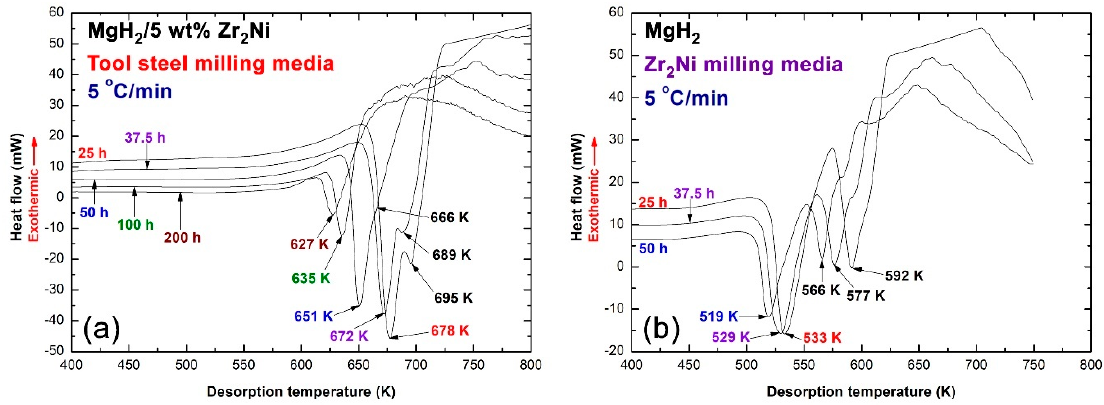
Figure 7. Normal differential scanning calorimetry (DSC) thermograms of the samples obtained after different RBM times (indexed inset of the figure) for ball milled ( a ) MgH 2 powders doped with 5 wt% Zr 2 Ni, using tool steel balls and ( b ) MgH 2 powders milled with Zr 2 Ni balls. All DSC measurements were conducted under 75 mL of continuous argon flow with a heating rate of 5 °C/min.